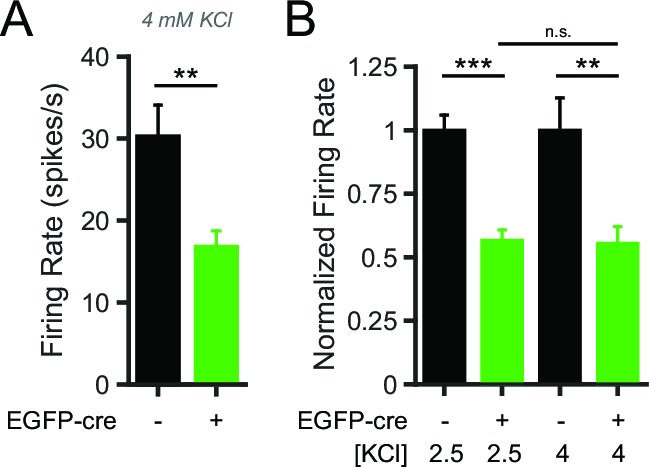
NALCN KO SNr neurons have lower firing rates in both low and high potassium conditions.(A) Mean firing rate of EGFP-cre negative (30.2 ± 3.9 spikes/s; n = 18) and positive (16.8 ± 2.0 spikes/s; n = 13) neurons from Nalcnfl/fl mice in elevated potassium (4 mM KCl) bath solution (unpaired t-test; **p=0.009). (B) Normalized mean firing rate of Nalcnfl/fl EGFP-cre negative and positive neurons in 2.5 mM and 4 mM KCl bath solution. n.s.p>0.05; **p<0.01; ***p<0.001; one-way ANOVA with Bonferroni post hoc correction.